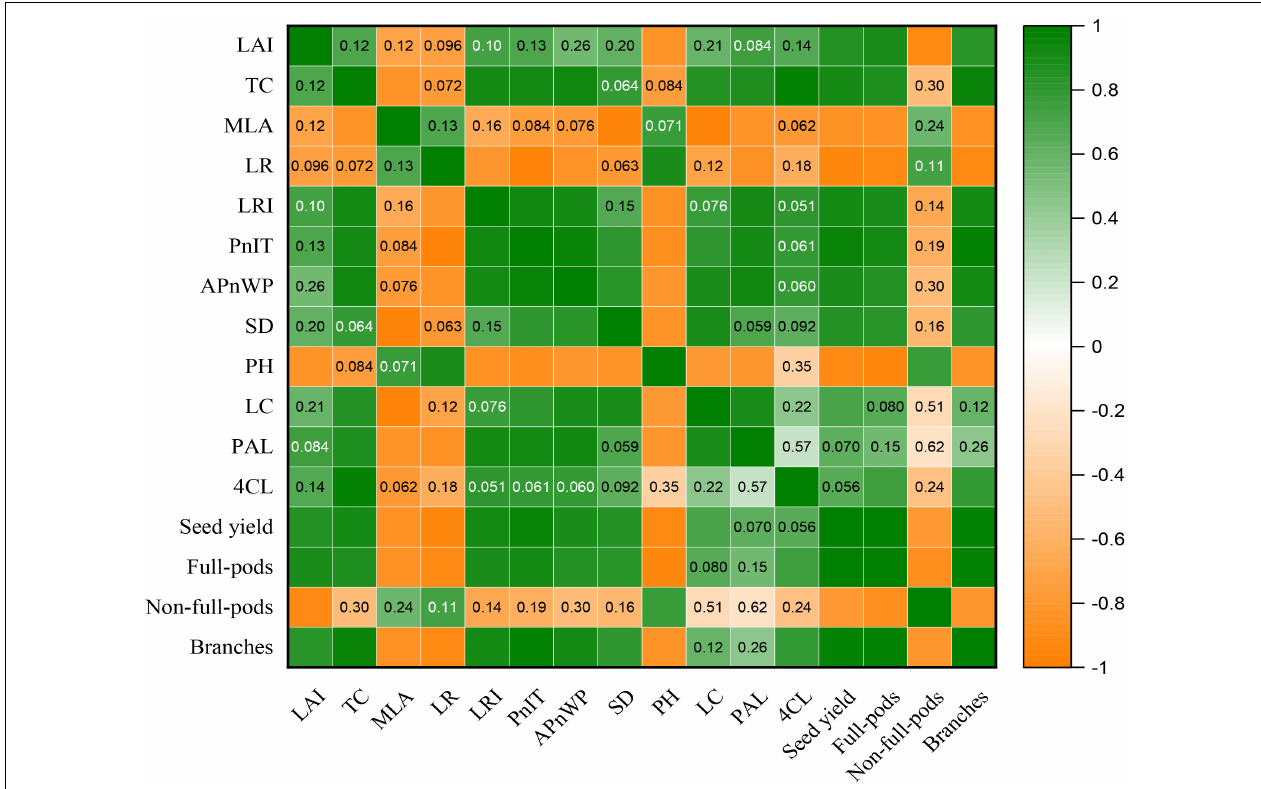
FIGURE 9 | Correlation analysis of LAI, TC, MLA, LR, LRI, the PnIT, the APnWP, SD, PH, LC, PAL, 4CL, seed yield, full-pods, non-full-pods, and branches by using the t -test at p ≤ 0.05 for both TL-1 and CD-16 in the strip intercropping. Orange means positive correlation, and green means negative correlation. The darkness of the color represents strength of correlation. The numbers in the boxes indicate p -value, and a box without numbers indicates a strong correlation.